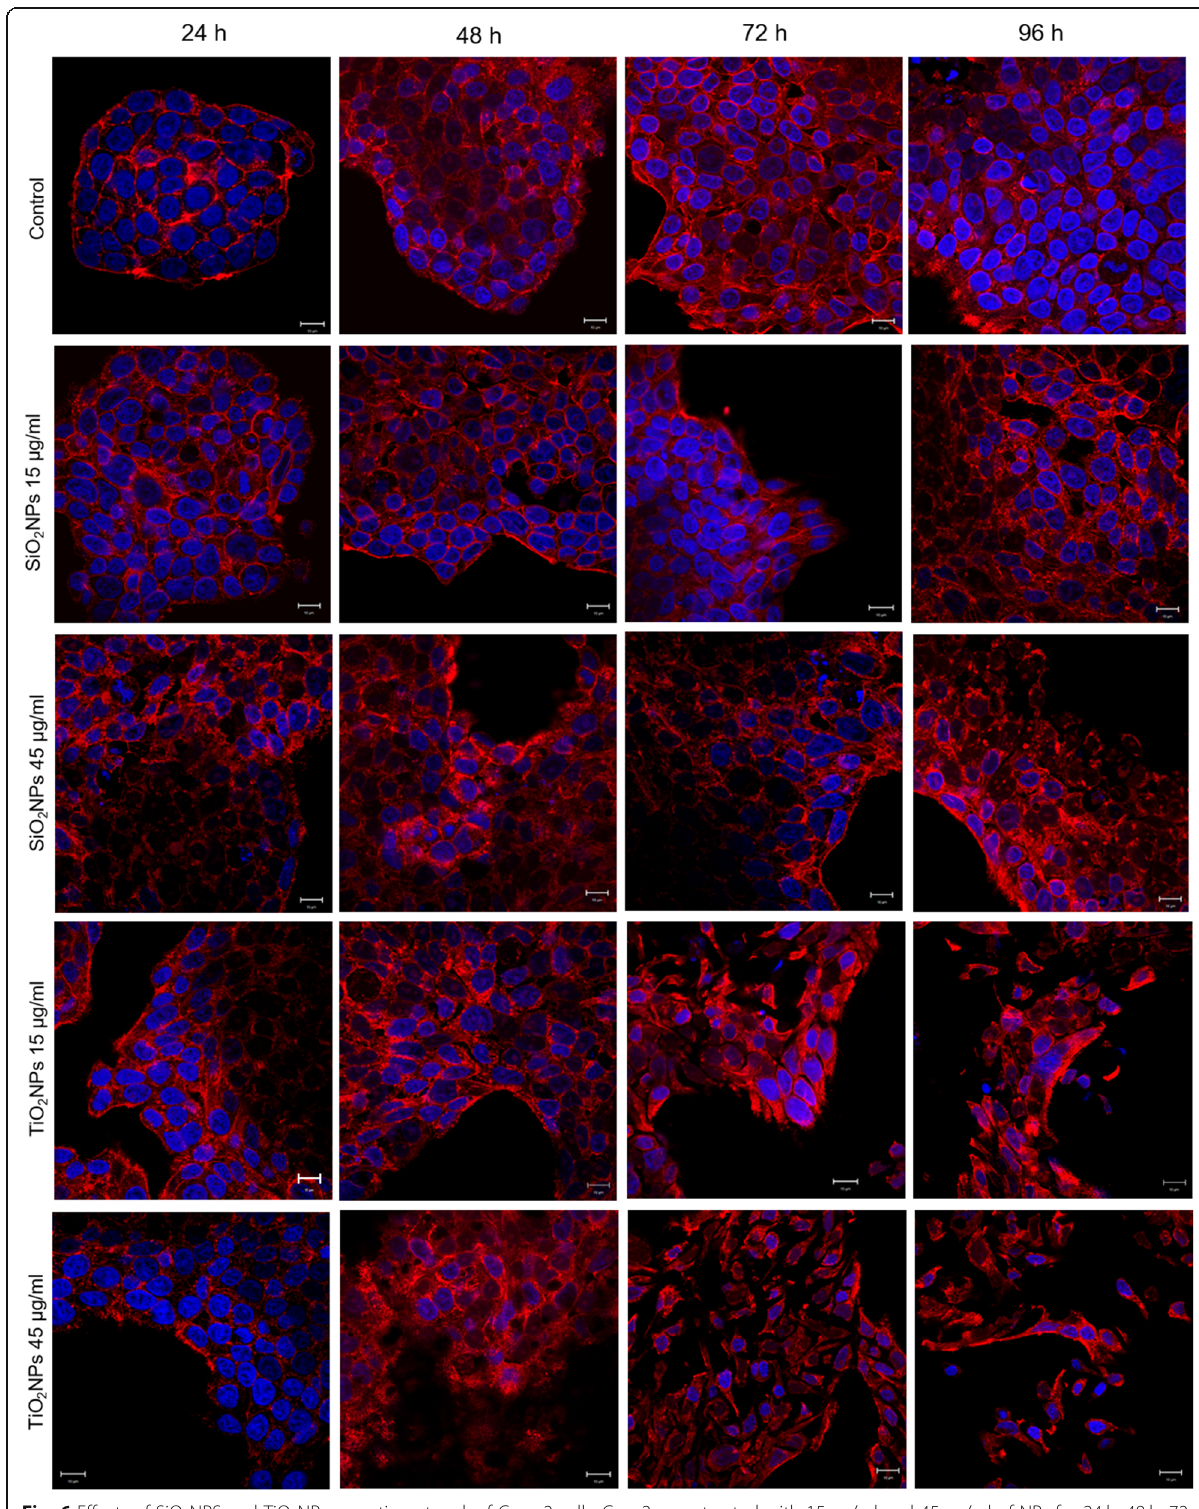
Fig. 6 Effects of SiO 2 NPS and TiO 2 NPs on actin network of Caco-2 cells. Caco2 were treated with 15 μ g/ml and 45 μ g/ml of NPs for 24 h, 48 h, 72 h, and 96 h; cells were fixed and then stained with Phalloidin – ATTO 488 and DAPI. The 2D images of cortical actin were acquired by a Zeiss LSM700 (Zeiss) confocal microscope equipped with an Axio Observer Z1 (Zeiss) inverted microscope using a × 100, 1.46 numerical aperture oil immersion lens. All data were processed by ZEN software